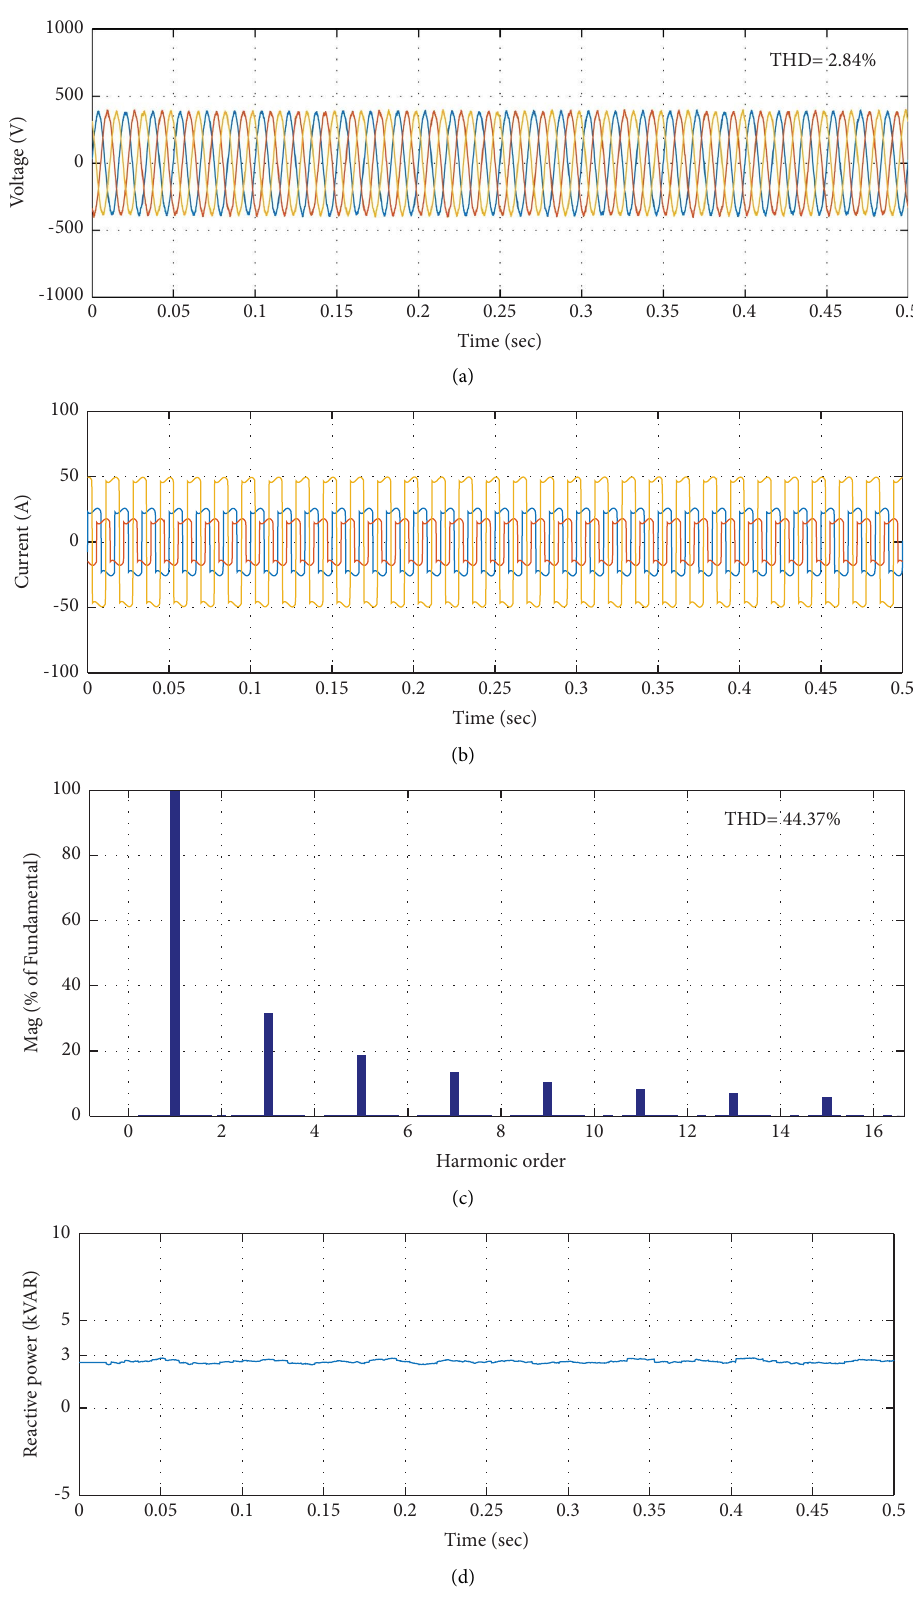
Figure 12: Performance during light nonlinear loading without SC-integrated APFs. (a) Load voltage waveform, (b) load current waveform, (c) FFT analysis of load current, and (d) reactive power of the